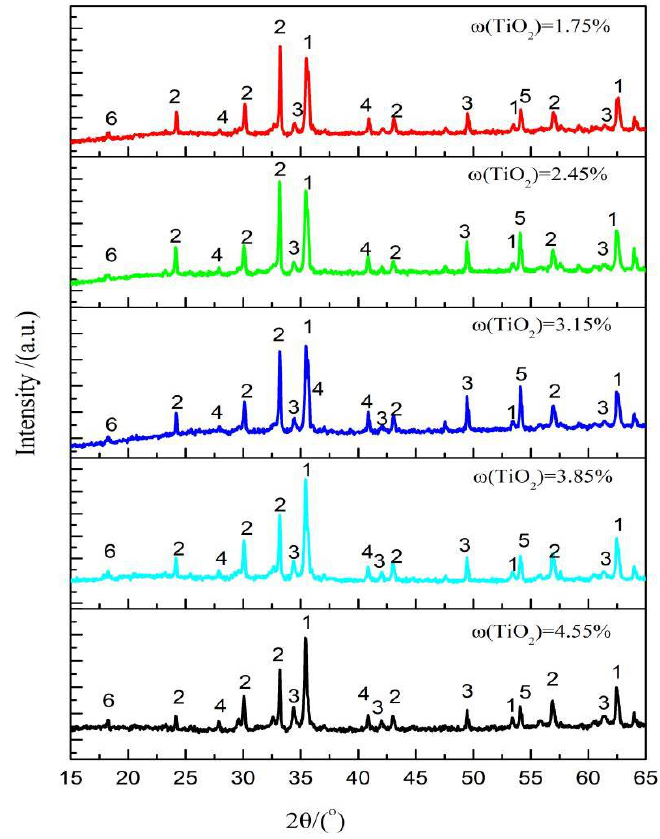
Figure 5. XRD of the LVTM sinter at different TiO 2 content: 1: magnetite; 2: hematite; 3: calcium ferrite; 4: perovskite; 5: silicate; 6: ilmenite.